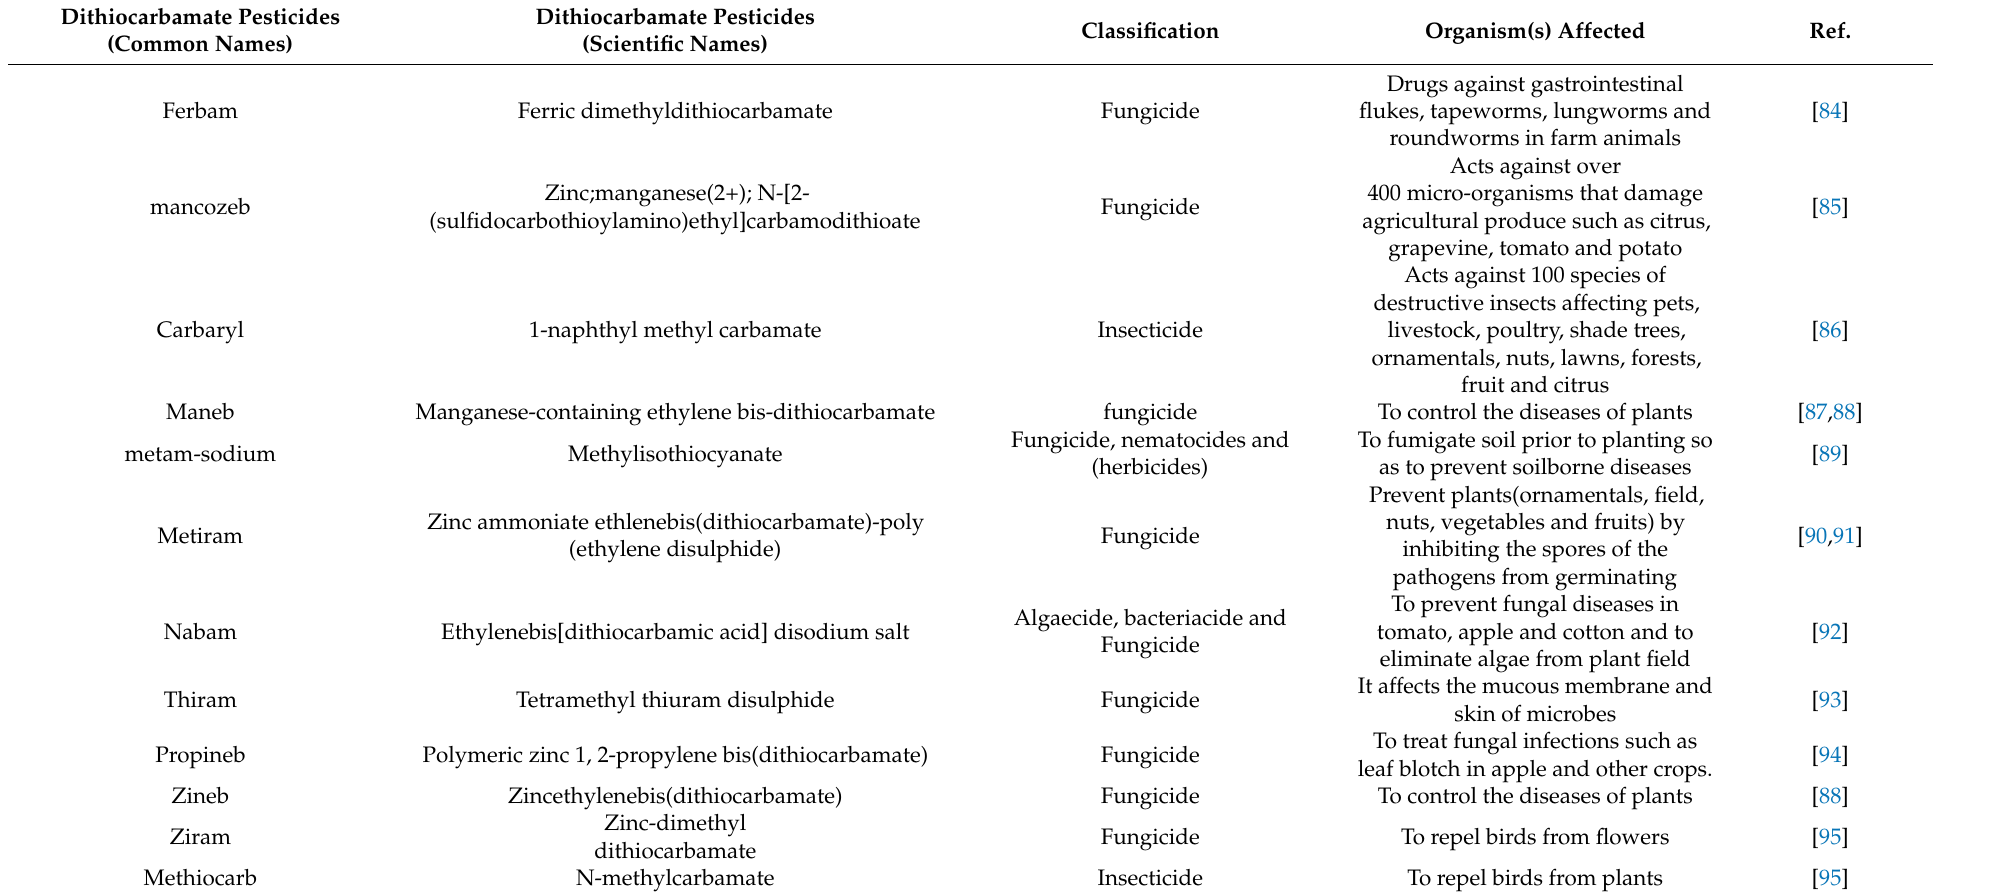
Table 4. Scientific name of common dithiocarbamate pesticides and the organisms